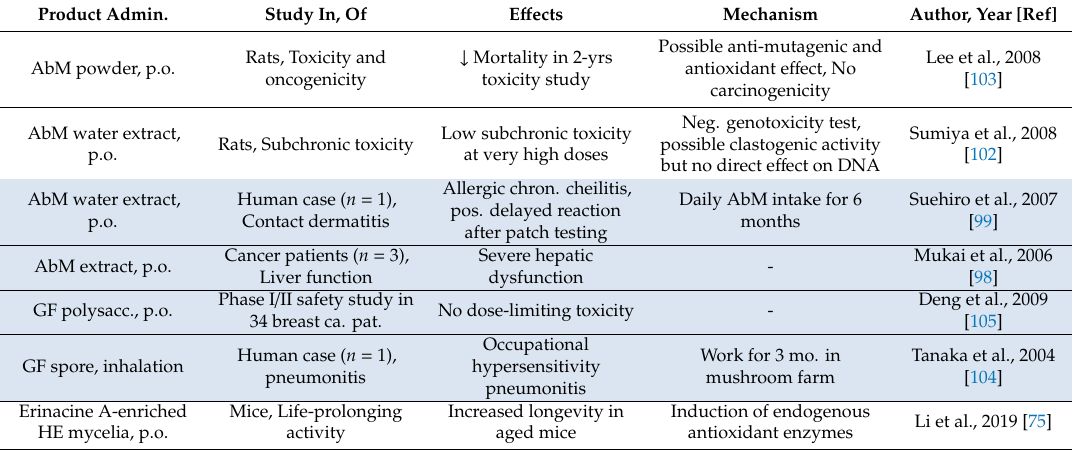
Table 7. Safety of Agaricus blazei Murill, Grifola frondosa and Hericium erinaceus (Human Studies) . Product